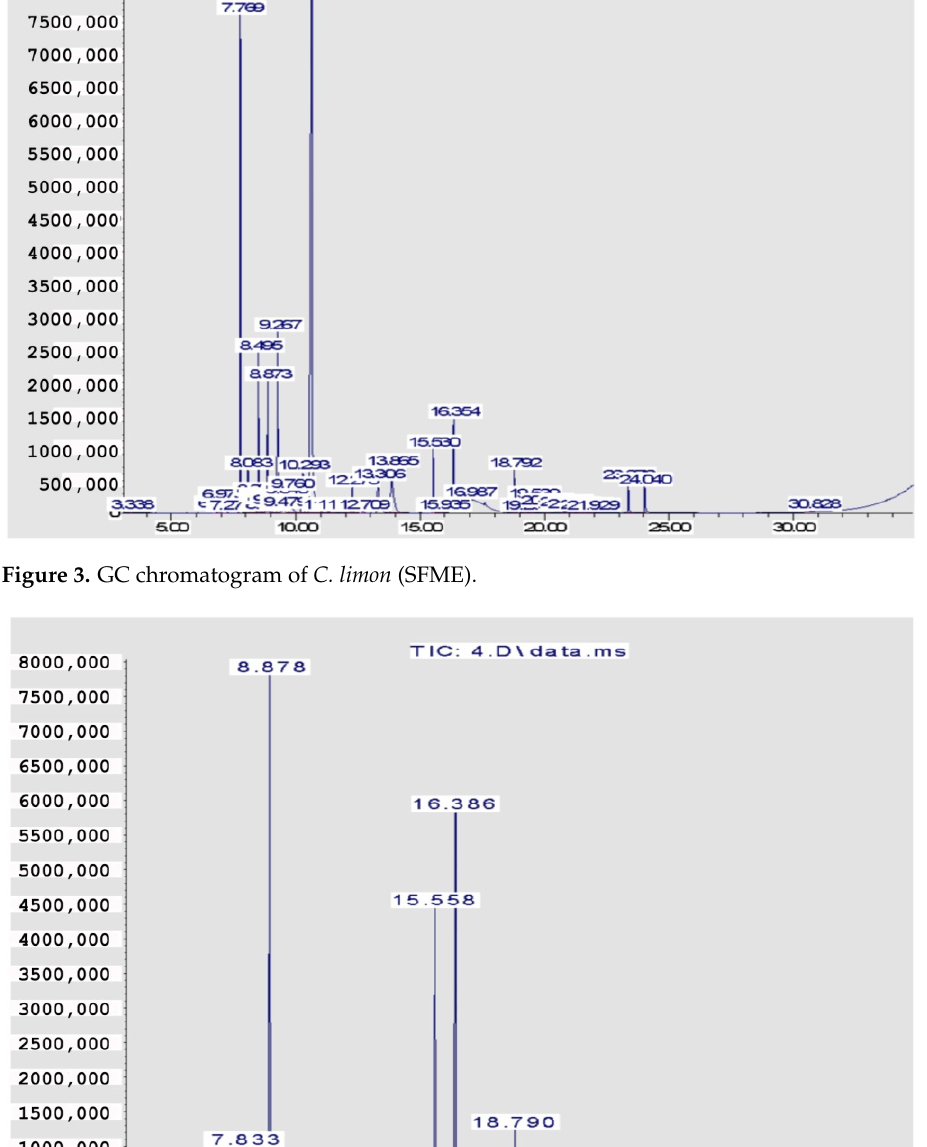
Figure 2. GC chromatogram of C. sinensis (SFME).